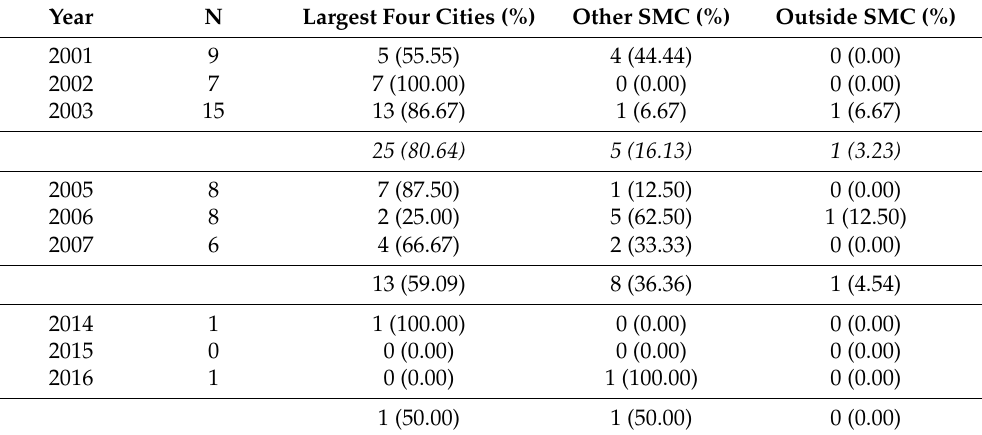
Table 5. Feline leukemia virus positive prevalence, stratified by source location within San Mateo County, among feral cats presented to the PHS Spay/Neuter Clinic in the years 2001–2003, 2005– 2007, and 2014–2016 *.